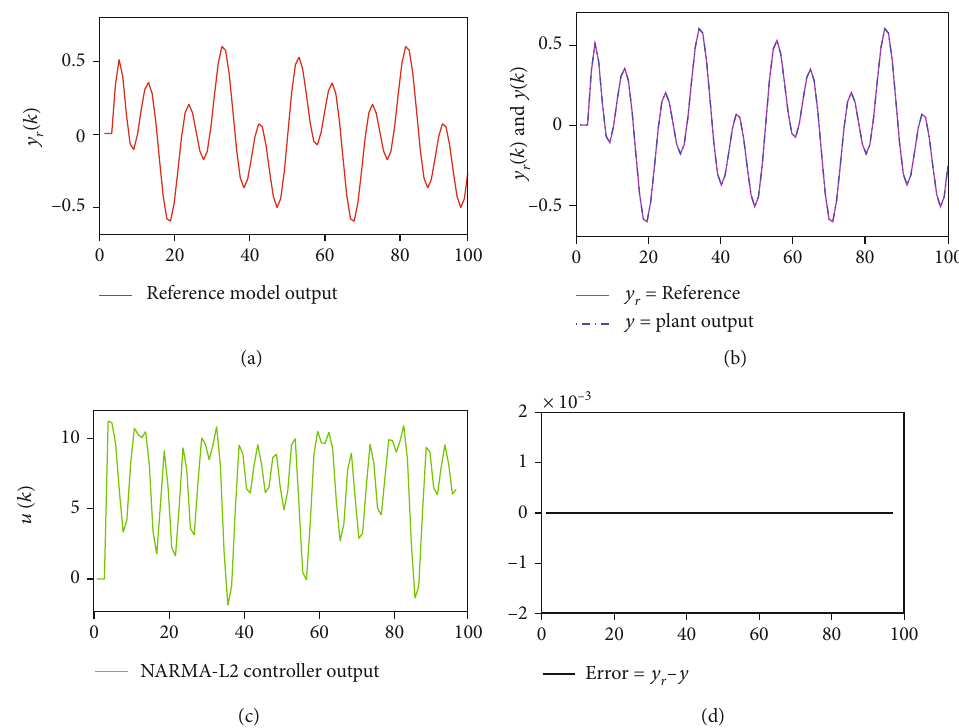
Figure 15: Example 3: (a) response of the reference model, (b) response of the plant under the adaptive NARMA-L2 controller, (c) controller output, (d) control error (using n = 2 and m = 2